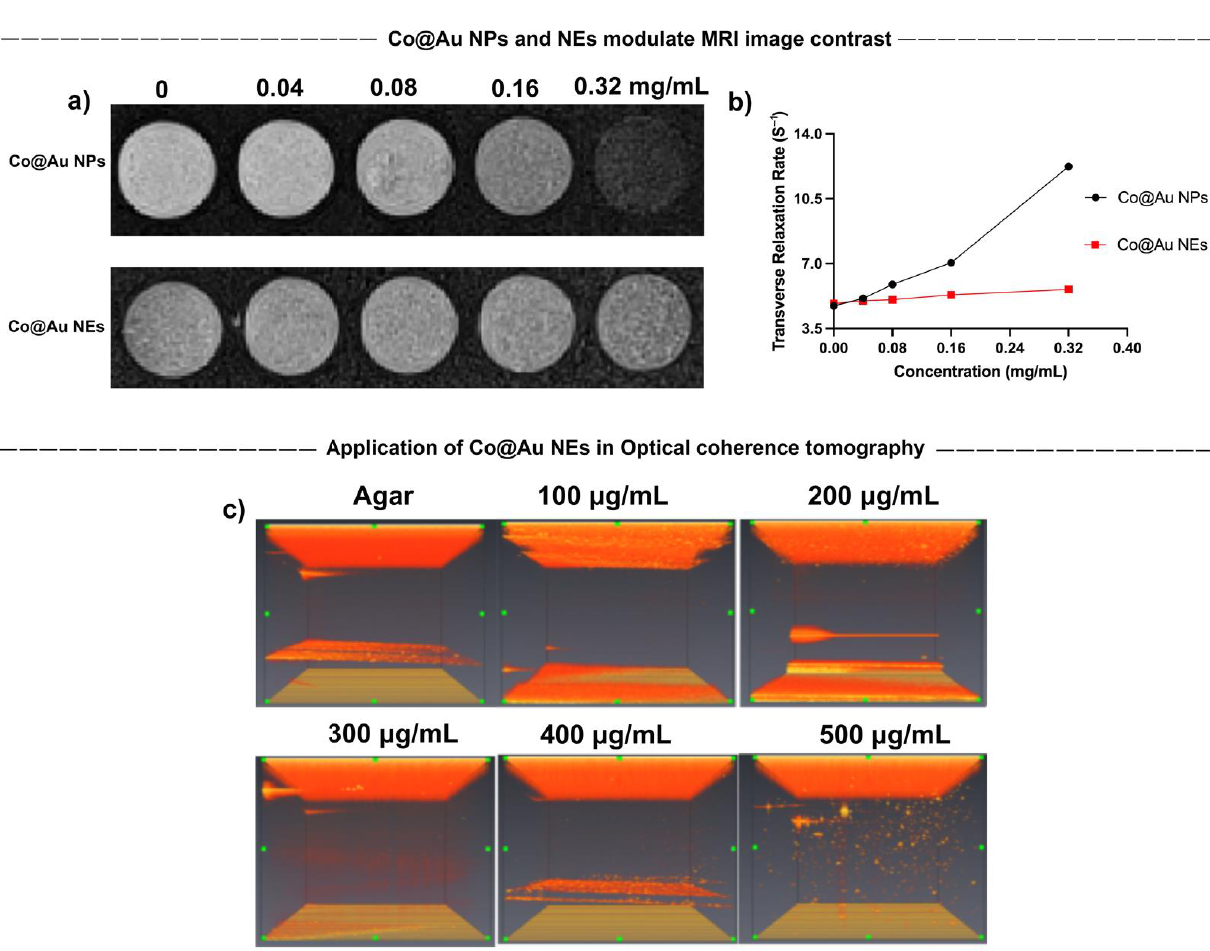
Figure 4. Characterization of round Co@Au nanoparticles (Co@Au NPs) and elliptical Co@Au (Co@Au NEs) nanoparticles as contrast agents in medical imaging. ( a ) MRI images of Co@Au NPs and NEs showing variation in image contrast in a concentration-dependent manner. Co@Au NPs displayed a higher contrast ability than Co@Au NEs. ( b ) Linear regression graph displaying relationship between Co@Au NPs and NEs concentration and transverse relaxation time. ( c ) Optical coherence tomography (OCT) images Co@Au NEs in a concentration-dependent manner. The images show dose-dependent change in contrast, highlighting Co@Au NEs as prospective medical imaging agent.